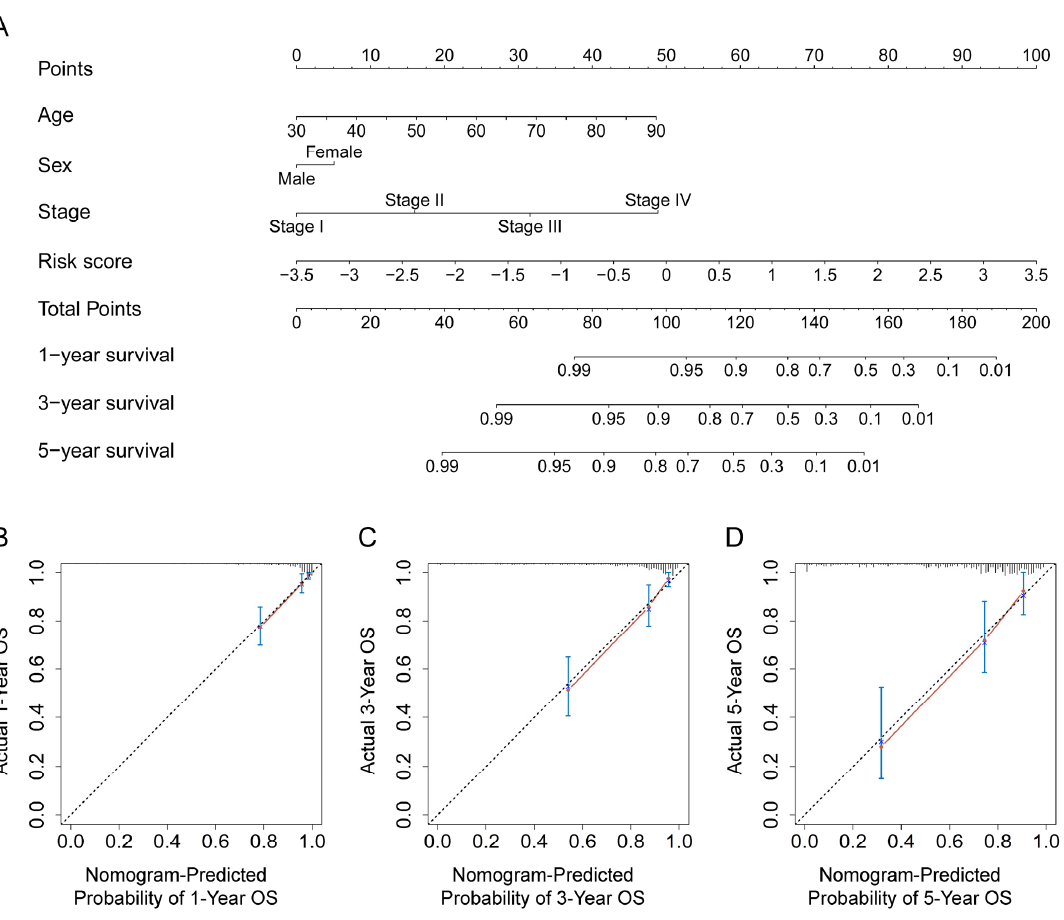
Figure 7. Construction and verification of the nomogram in the training set. ( A ) The established nomogram, which contains several indicators, such as age, sex, TNM stage, and risk score, can predict the OS rate of 1, 3, and 5 years for CRC patients in the training set. The calibration curves at 1-year ( B ), 3-year ( C ), and 5-year ( D ) OS of the nomogram in the training set show the predicted result of the nomogram is close to the actual OS rate.